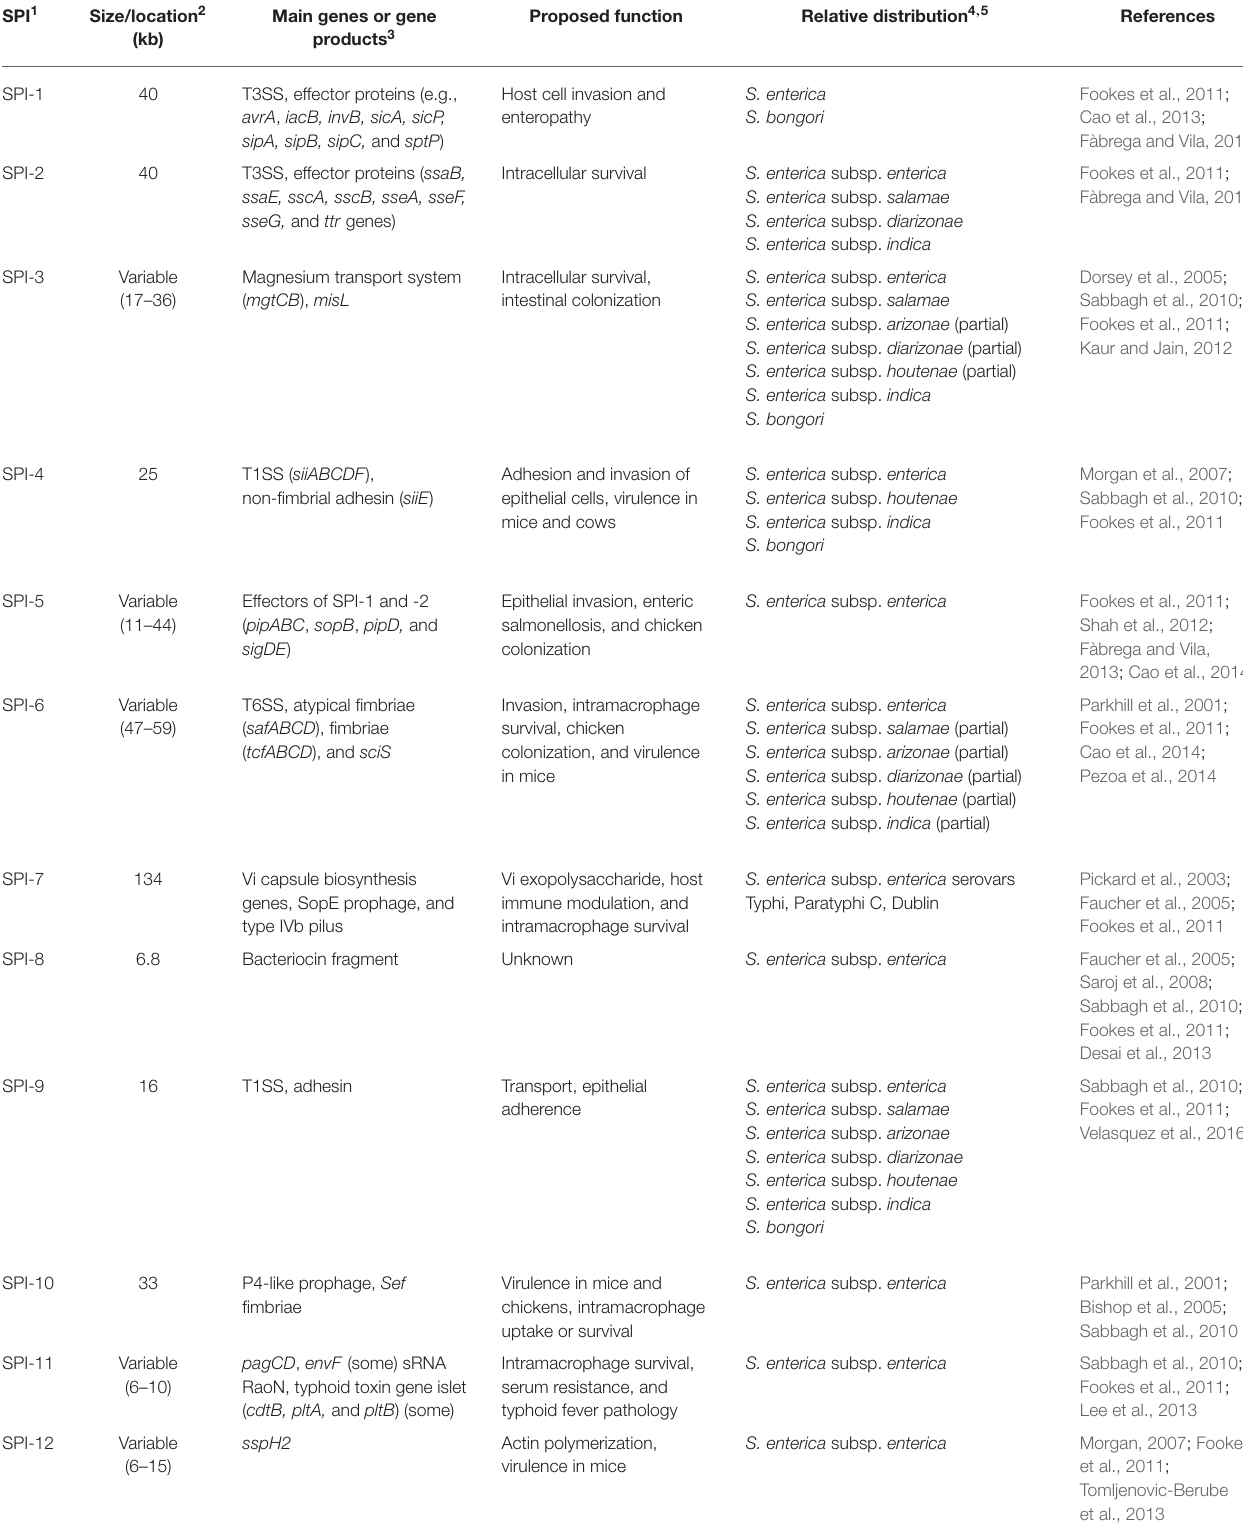
TABLE 1 | Current understanding of the size, function, and distribution of Salmonella pathogenicity islands (SPIs) among Salmonella. SPI